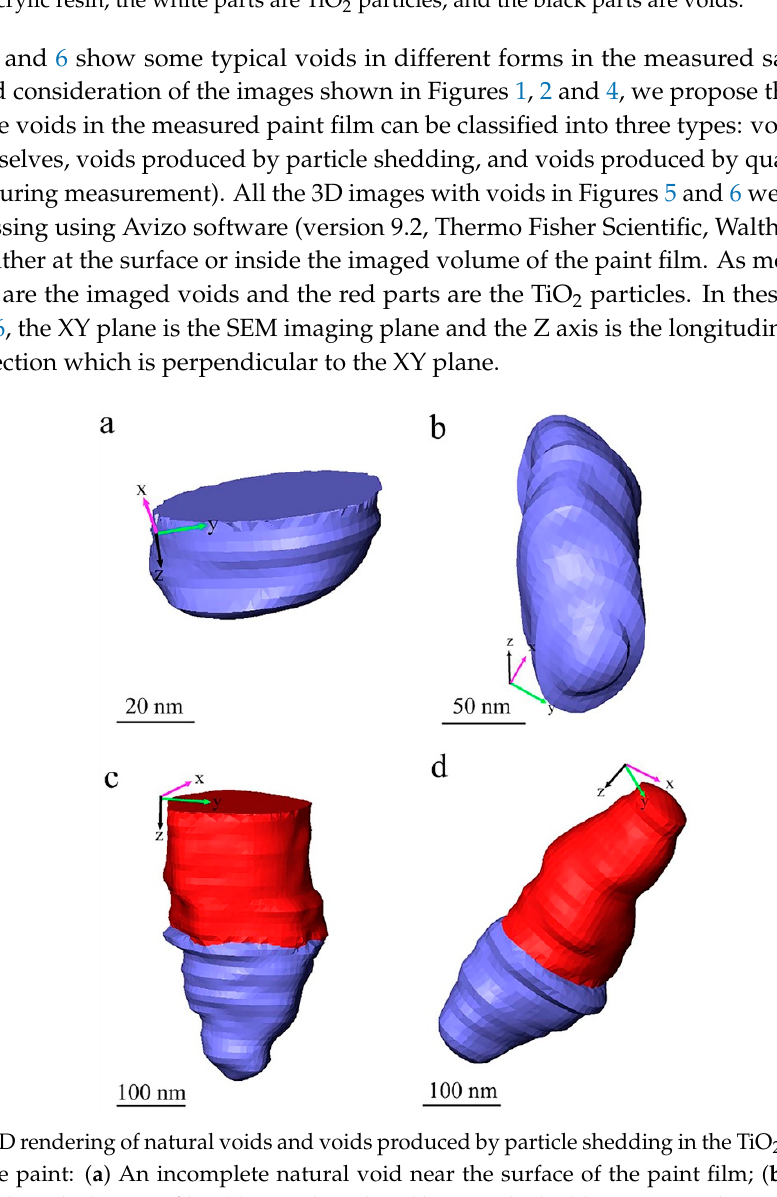
Figure 4. The 56th 2D image of the TiO 2 pigmented waterborne paint film in the XZ direction. The grey parts are acrylic resin, the white parts are TiO 2 particles, and the black parts are voids.